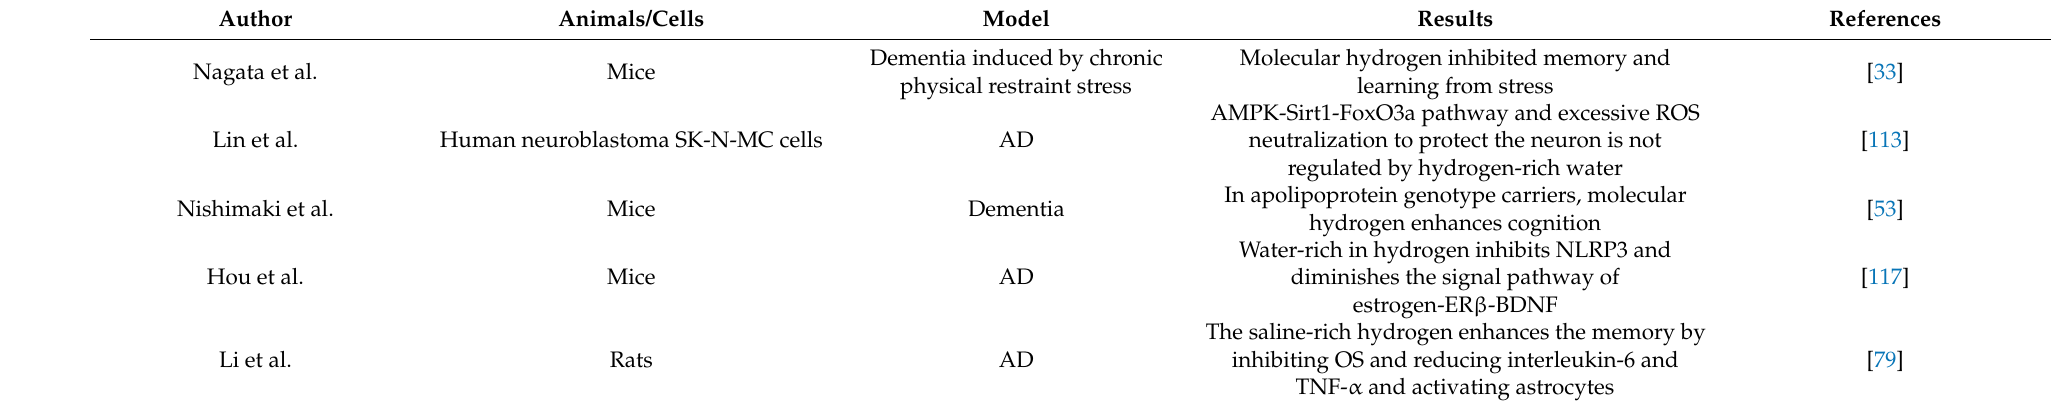
Table 2. Experimental studies related to H 2 in Alzheimer’s disease